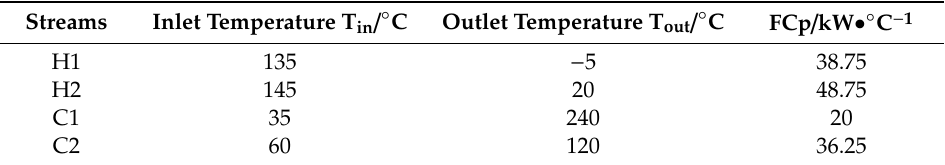
Table 1. Stream data for case 1.